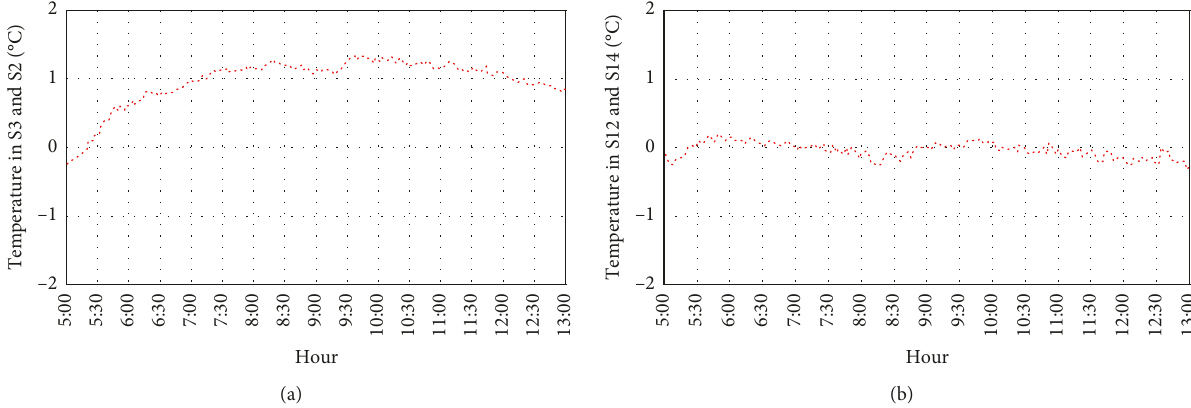
Figure 7: Differences between the temperatures recorded by the thermistors placed in S3 and S2 (a) and S12 and S14